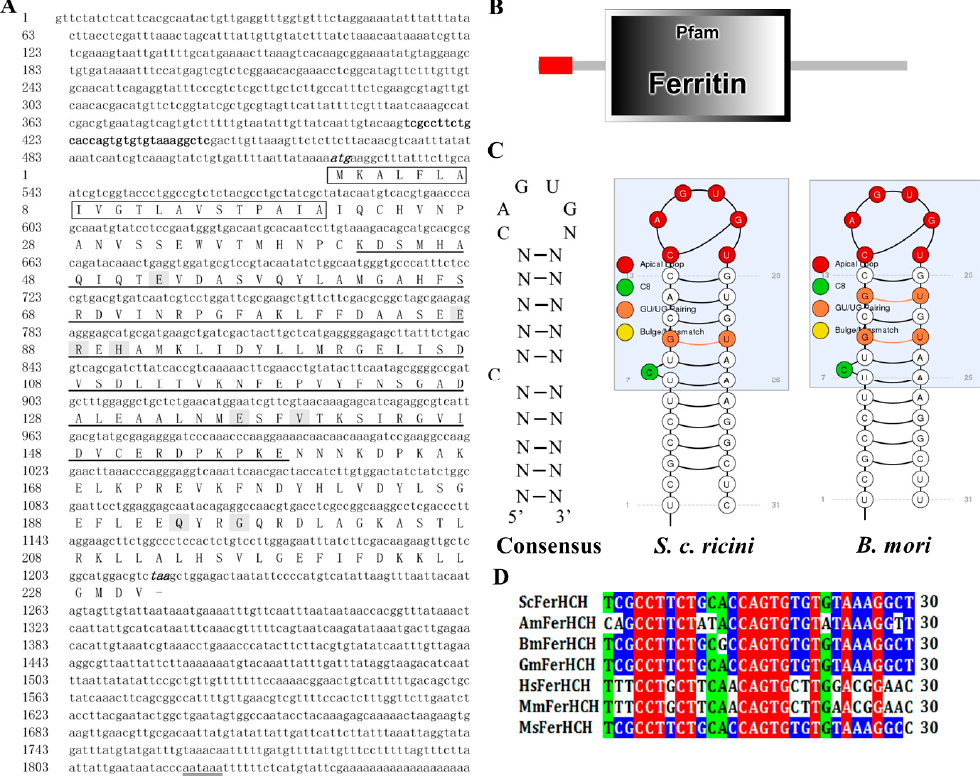
Figure 1. ( A ) Complete nucleotide and deduced amino acid sequence of the S. c. ricini ferritin heavy chain subunit ( ScFerHCH ) gene. Numbers on the left side represent nucleotide and amino acid positions. The putative IRE in the 5 ′ -UTR is shown in black bold, and the polyadenylation signal in the 3 ′ -UTR is double underlined. The initiation codon (ATG) and termination codon (TAA) are indicated in black italics. The signal peptide is represented in the black box. The ferritin domain is highlighted in a single line, and the eight metal ligands are shaded; ( B ) Structural domain of ScFerHCH predicted using the SMART program. The red box indicates the signal peptide and the black box represents the ferritin domain; ( C ) Predicted IRE stem-loop structures of the ferritin heavy chain subunit from S. c. ricini (Accession no. 2045712 ) and B. mori (Accession no. AK386476); ( D ) Alignment of IREs of ScFerHCH with other insect ferritin. The conserved nucleotides for IREs were marked in red. Identical amino acids are highlighted in green, similar amino acids are highlighted in blue.